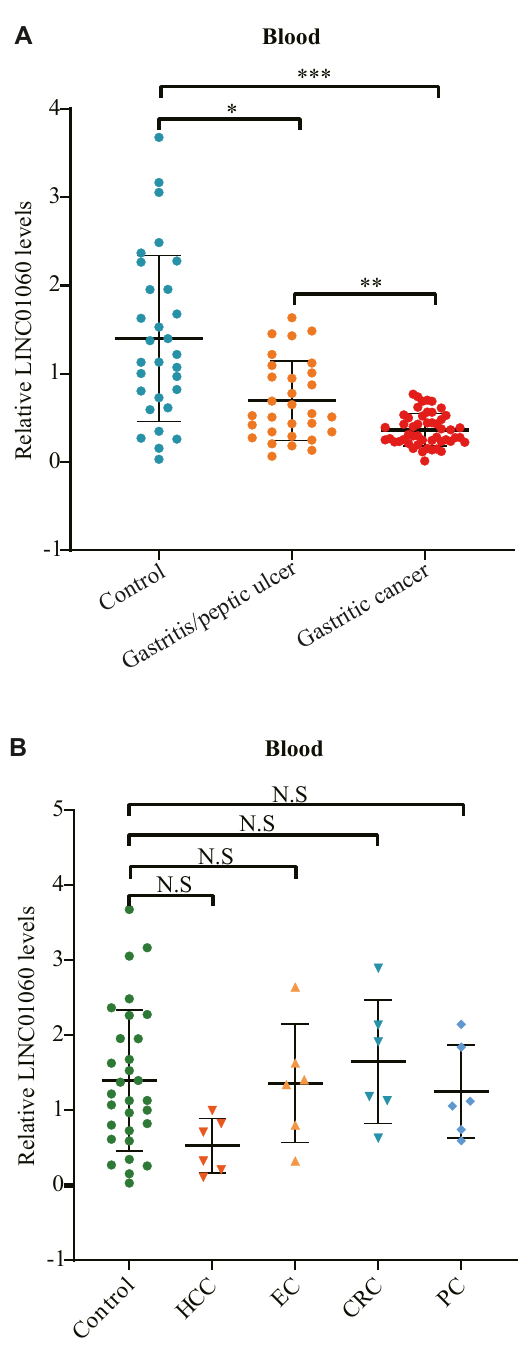
Figure 2: The expression of whole blood LINC01060 in different gastrointestinal